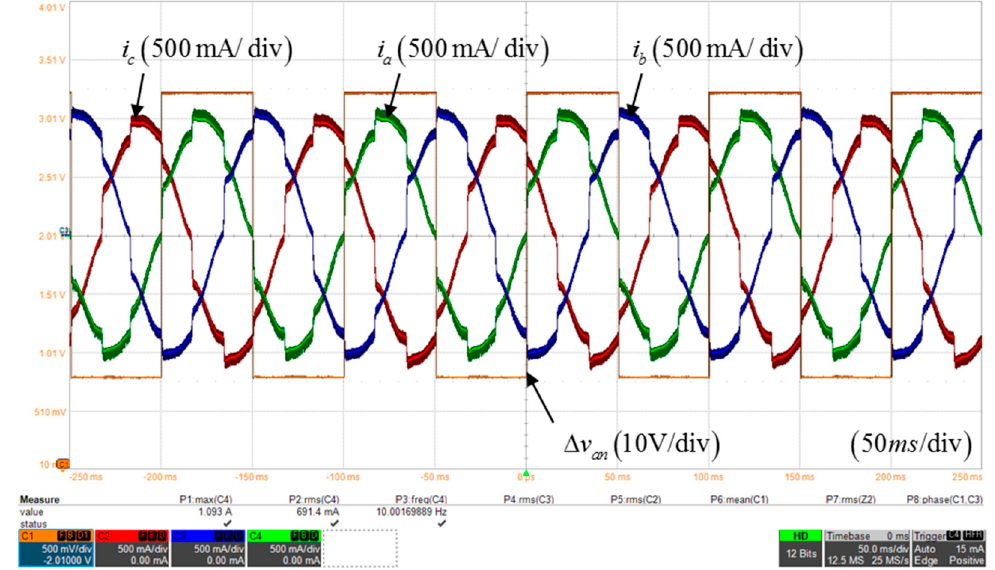
Figure 24. Three-phase currents waveforms and a-phase dead-time compensation pole voltage waveform when conventional DTCS considering only T d was